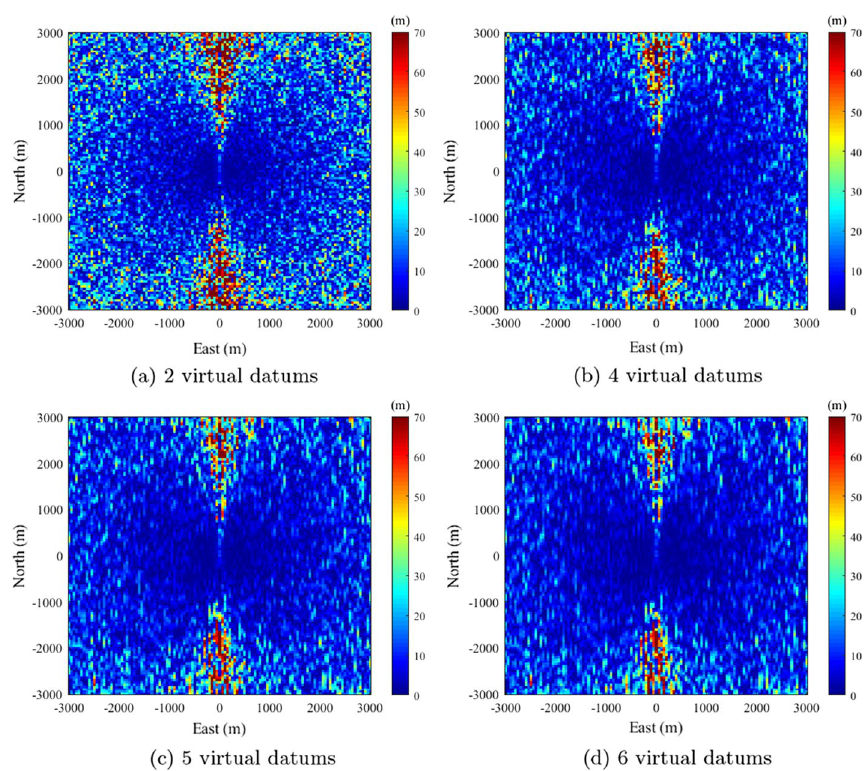
Fig. 7 Positioning error under different virtual